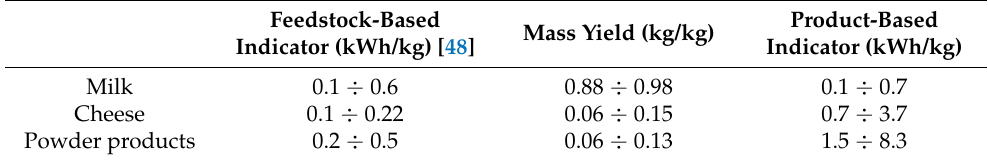
Table 1. Product-based and feedstock-based energy indicator